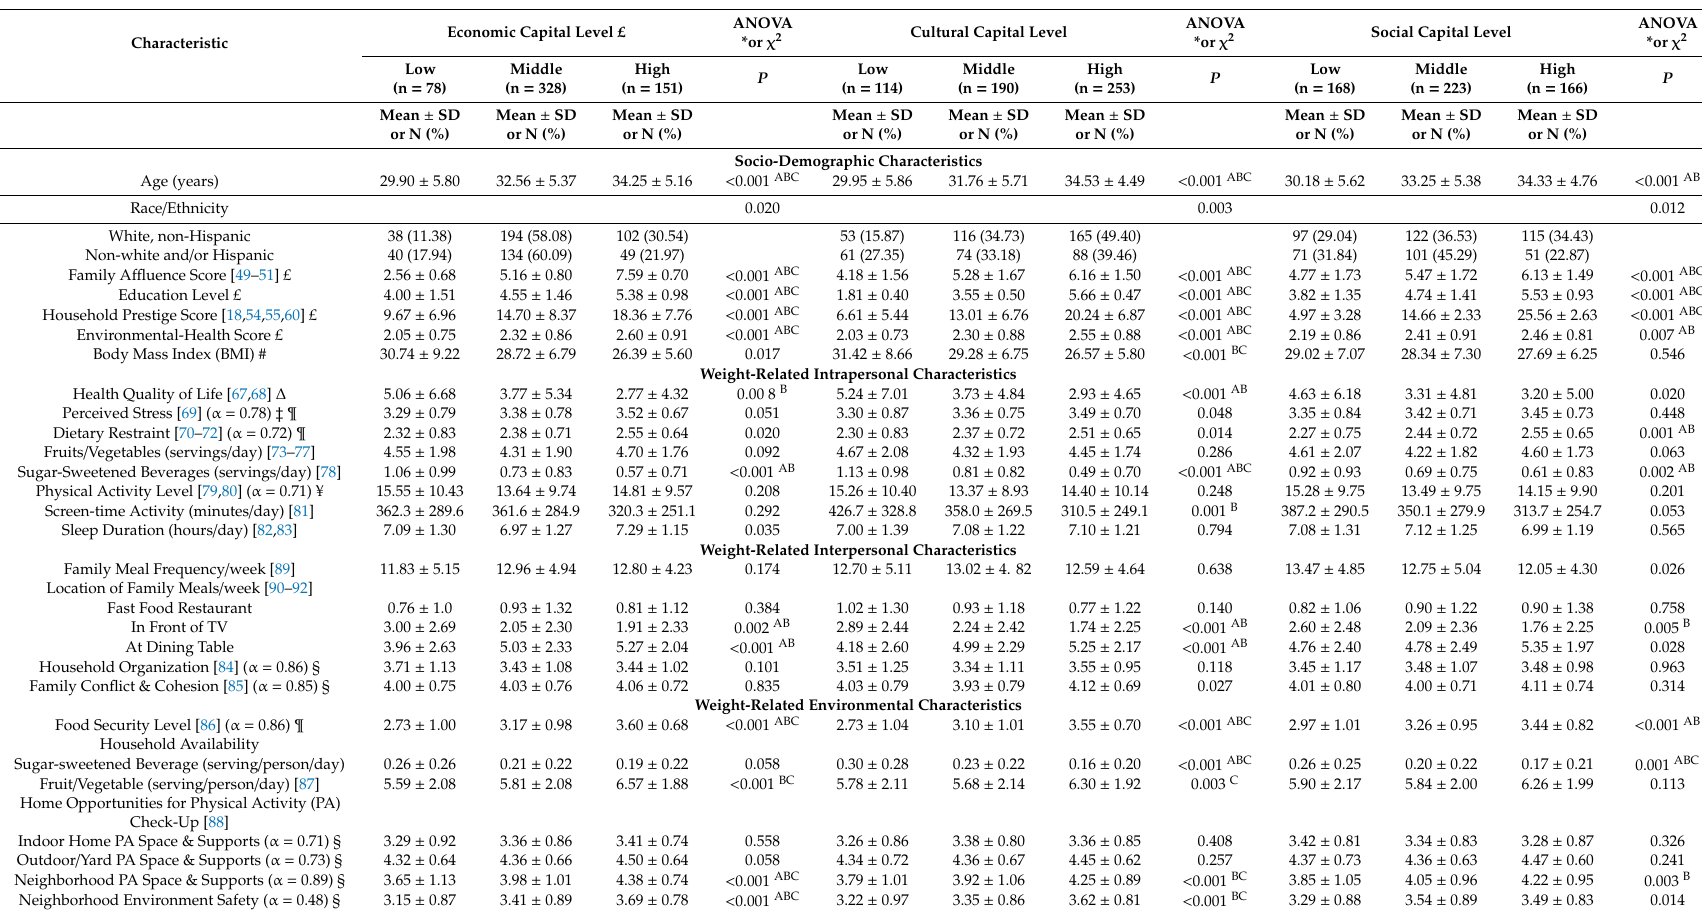
Table 1. Comparison of socio-demographic and weight-related characteristics (grouped by intrapersonal, interpersonal, and environmental characteristics) by level of economic, cultural, social, environmental-health capitals and SES index tertile (N =